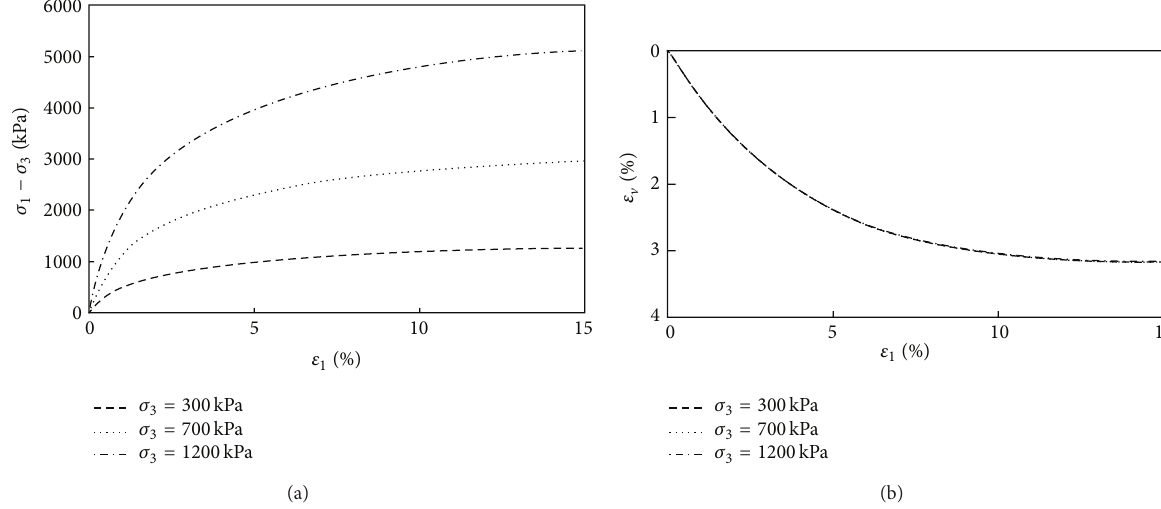
Figure 1: Simulation of stress-strain relationships for Original PZ-III